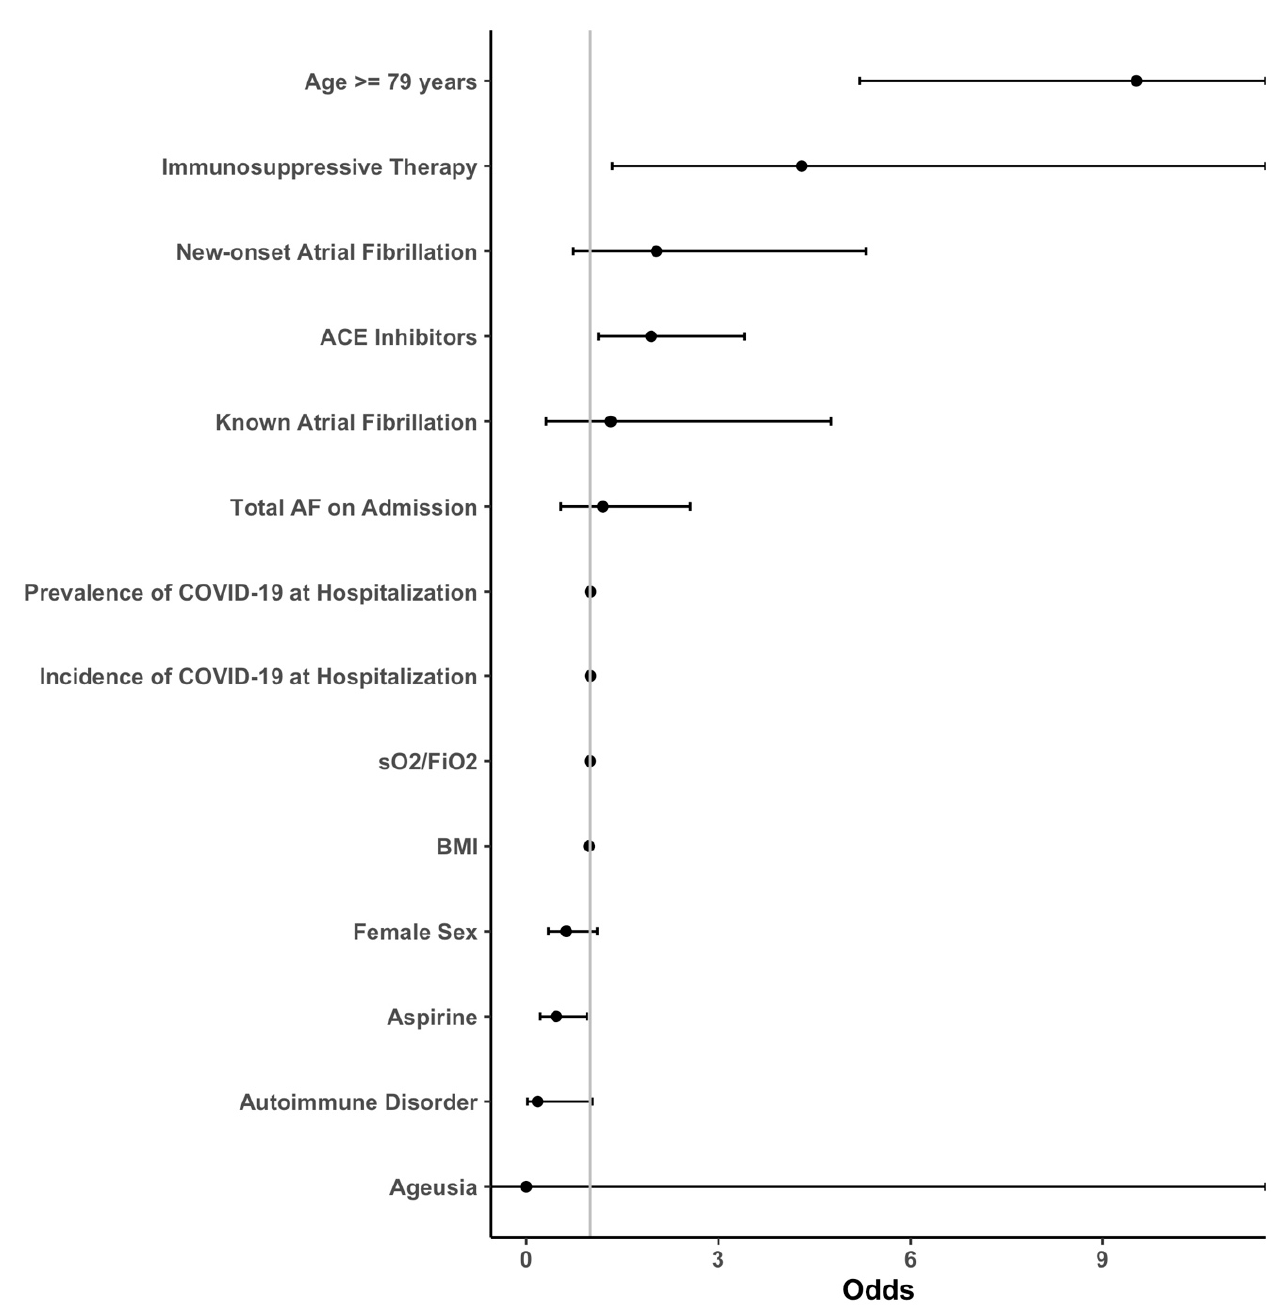
Figure 2. Forest plots of the primary outcome “In-Hospital Death”. The transfer risk for in-hospital death was assessed by sequential logistic models with a stepwise reduction based on the Aikake information criterion. Abbreviations: ACE = angiotensin-converting enzyme, AF = atrial fibrillation, BMI = body mass index, sO 2 = oxygen saturation, FiO 2 = fraction of inspired oxygen, COVID-19 = coronavirus disease 2019.